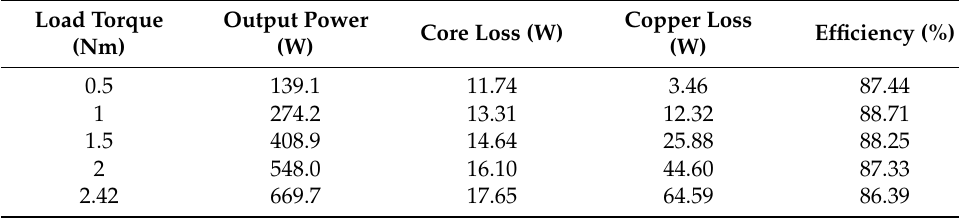
Table 4. Analysis results of the 2D corrected model.